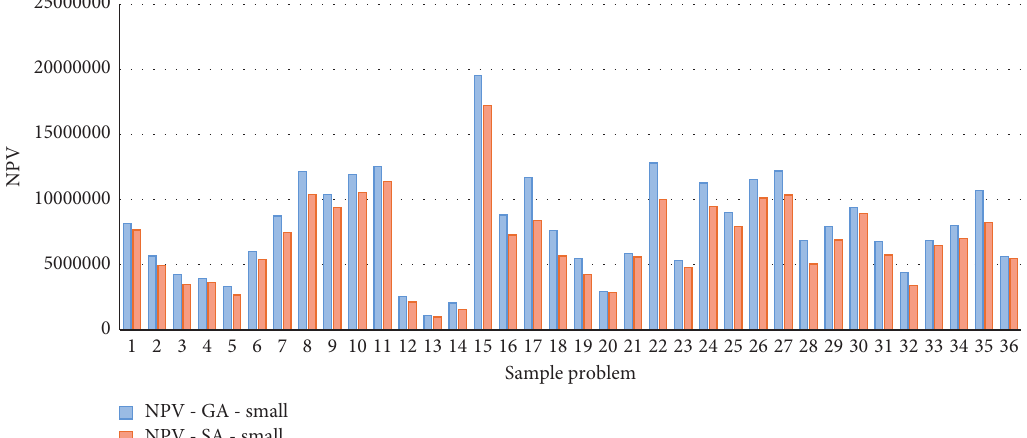
Figure 3: Comparison chart of net present value obtained by GA and SA algorithms in small problems.